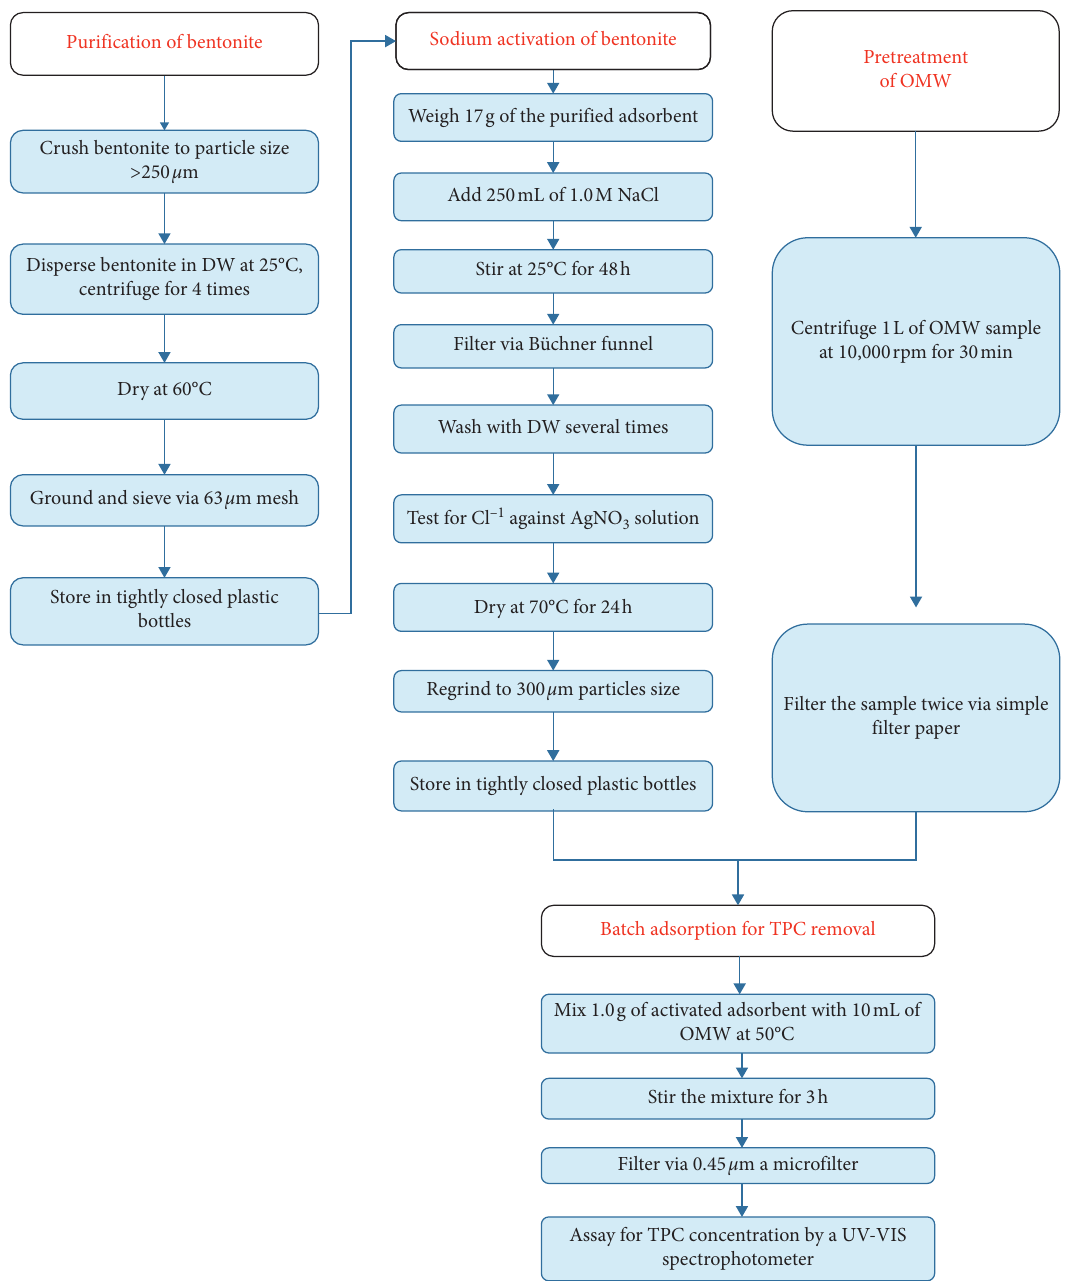
Figure 8: Protocol for OMW treatment and assaying for TPC concentration using AJB